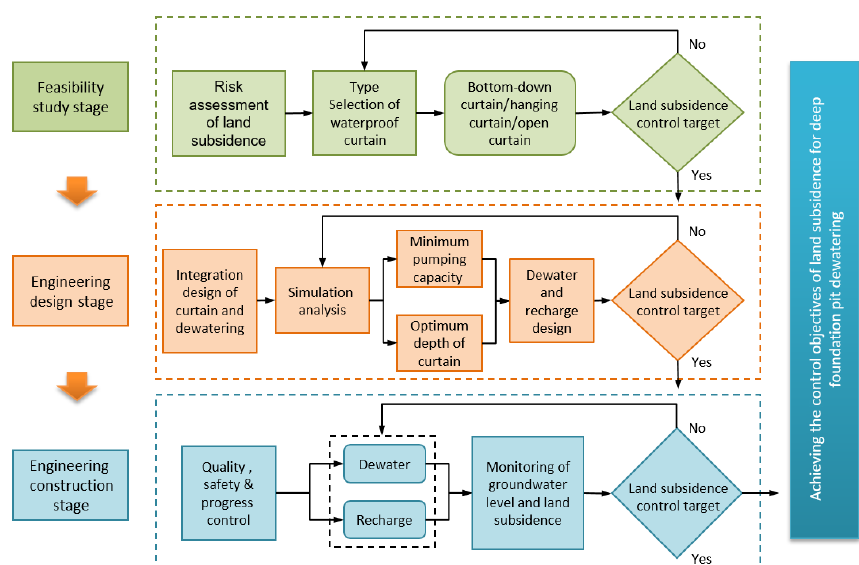
Figure 1. Technical path of land subsidence control for deep foundation pit